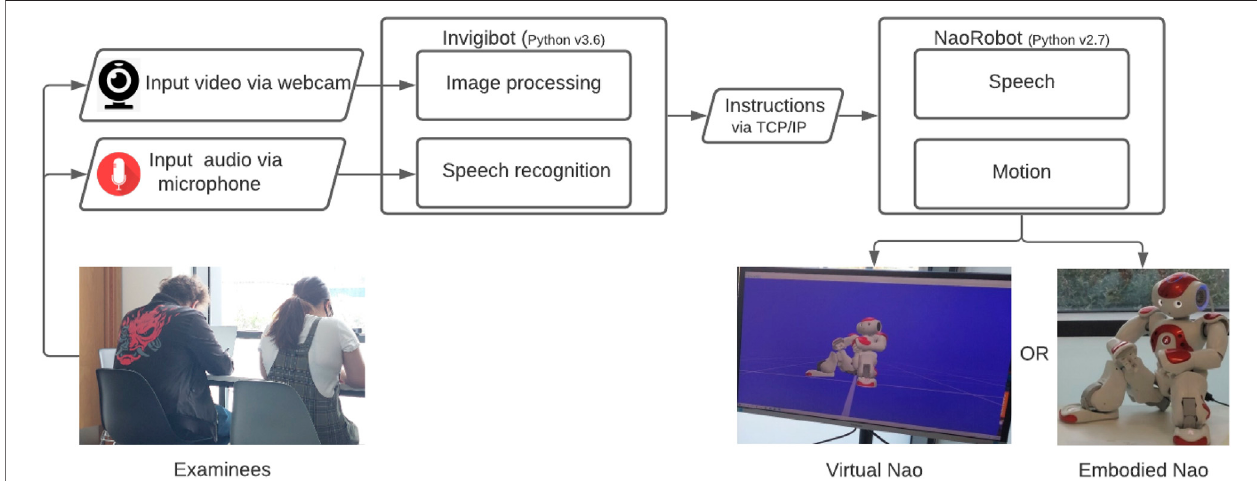
FIGURE 1 | Robot invigilator system. Left: two examinee participants performing the task in the experiment. Right: the virtual Nao robot in Choregraphe software (left) and physical Nao robot (right) as used in the experiment.